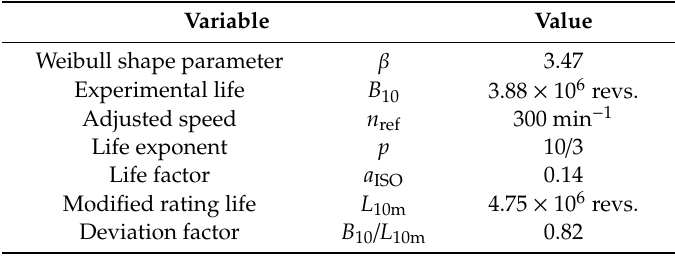
Table 5. Results of the fatigue life of tailored forming bearings and comparison with the calculated life of conventional